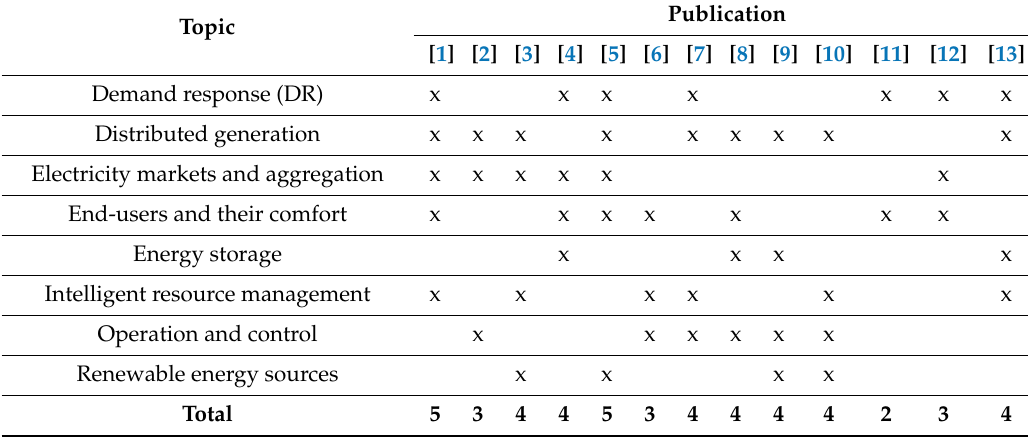
Table 1. Topics covered in each